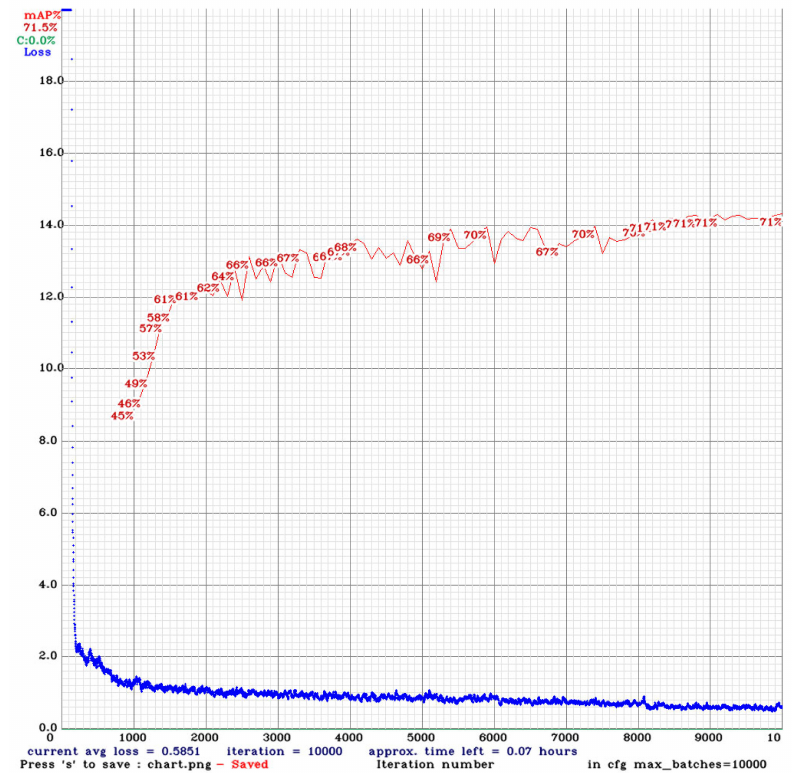
Figure 8. The performance of YOLOv4-Tiny-3l (864) in the HAIDA dataset.